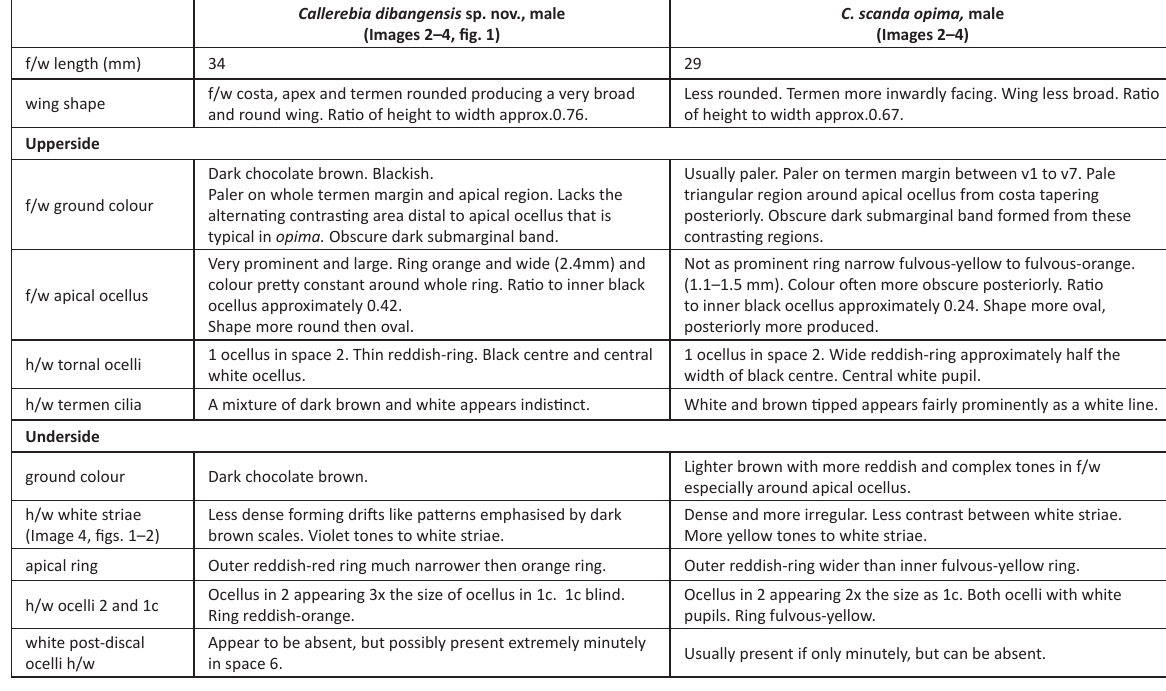
Table 2. Key identification features of male Callerebia species. Eastern Himalayan (roughly east of Eastern Nepal) species with a large to very large ocellus that substantially occupies the apical region of the upper f/w. Ring colour usually orange fulvous but may be also be yellowish-orange to reddish. Ocellus outer rings often irregular especially when ocellus ring is wide. Under h/w with prominent white striations overlaid with strong to weak bands and/or variegation. Often large butterflies. These species differ significantly in wing shape from C. dibangensis sp. nov.: f/w less rounded and more produced; h/w produced and with lobe; under h/w overlaid with bands and